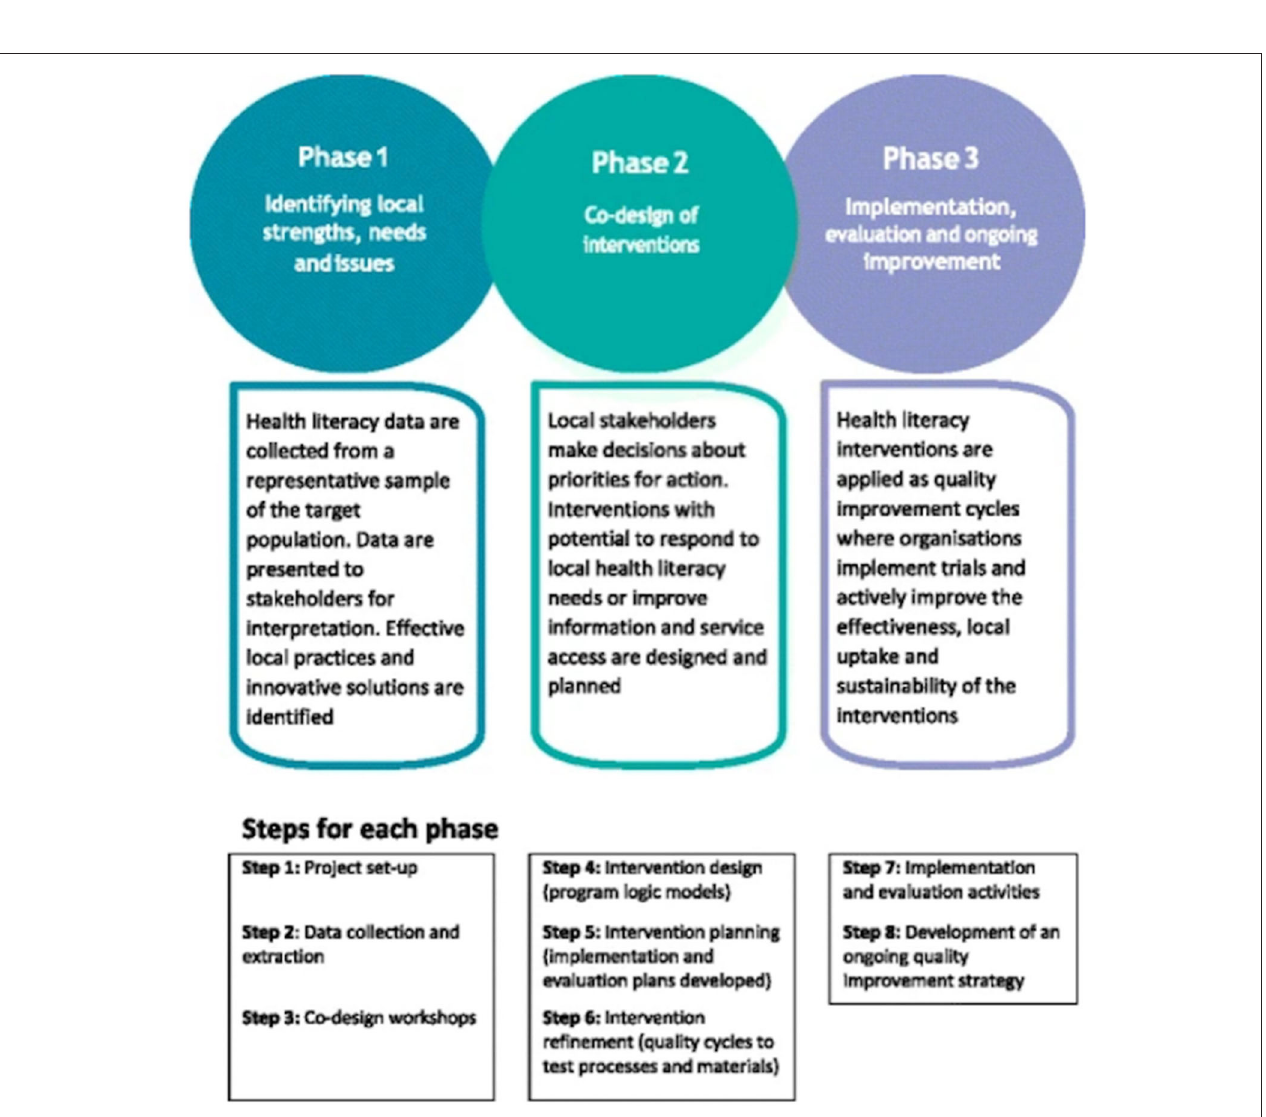
FIGURE 1 | The Ophelia (Optimzing Health Literacy and Access) process. Source: Reproduced from Beauchamp et al. Figure 1, p. 5 (26).